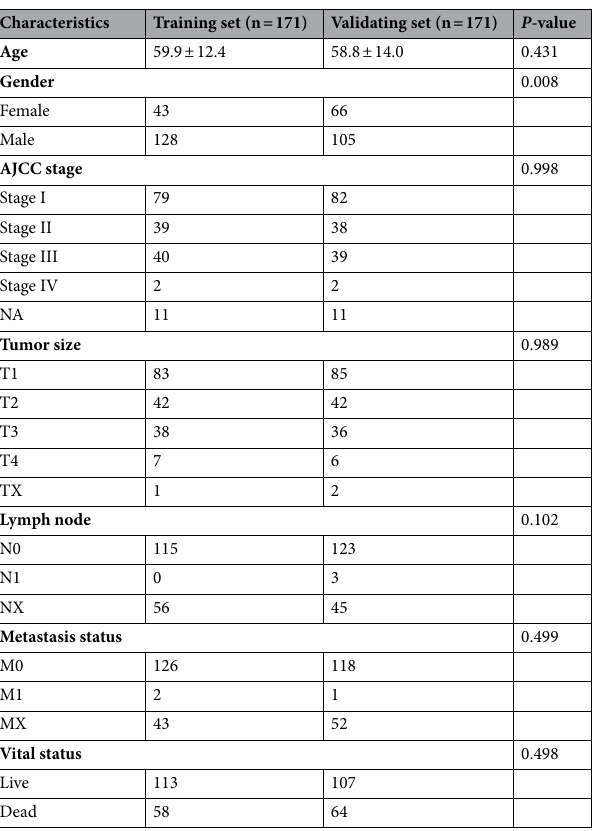
Table 2. Clinical characteristics of HCC patients in TCGA. HCC hepatocellular carcinoma, TCGA The Cancer genome atlas, AJCC American Joint Committee on Cancer.